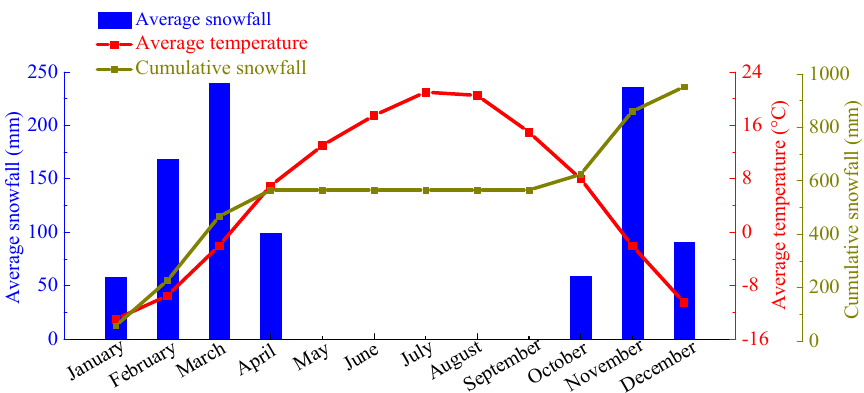
Figure 4. Average climate data from 2010 to 2020 at Yanji, Jilin Province.